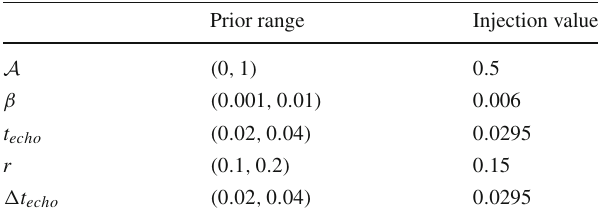
Table 1 The prior range of echo parameters. The prior distribution of each parameter is uniform over the respective prior range. There is an upper limit on A ’s prior range since the amplitude of echoes can not be greater than the amplitude of the IMR signal. β is the width of the echo Gaussian profile. t echo and (cid:3) t echo are approximately the same, both of which are allowed to vary independently within 1% of their respective maximum values. r is defined in Eq.